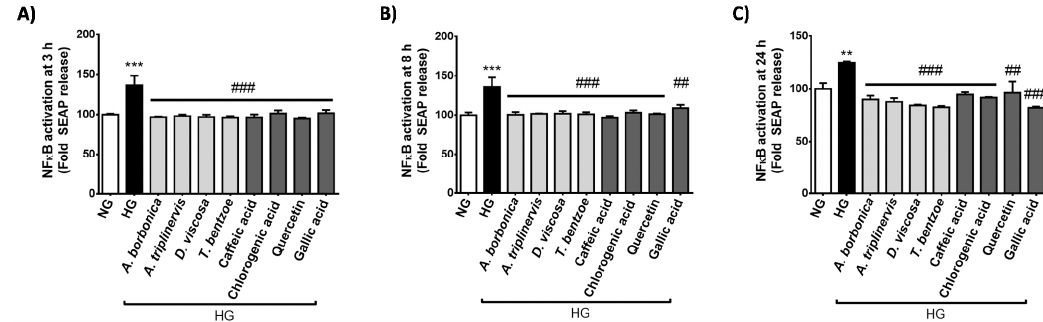
Figure 2. Effect of hyperglycemic condition and polyphenols on the transcriptional activity of NF κ B in cerebral endothelial cells. Cells were exposed to normoglycemic condition (NG) or hyperglycemic condition (HG) in the presence or not of each polyphenol-rich plant extract (10 μ M GAE) or a pure polyphenol (10 μ M). Relative NF κ B/SEAP activity was determined by Quanti-Blue assay at 3 h ( A ), 8 h ( B ) and 24 h ( C ) and expressed as the percentage of the control NG condition. Data are means ± SEM of three independent experiments (three cellular passages). **: p <0.01 and ***: p <0.005 as compared to NG; ## : p <0.01 and ### : p <0.005 as compared to